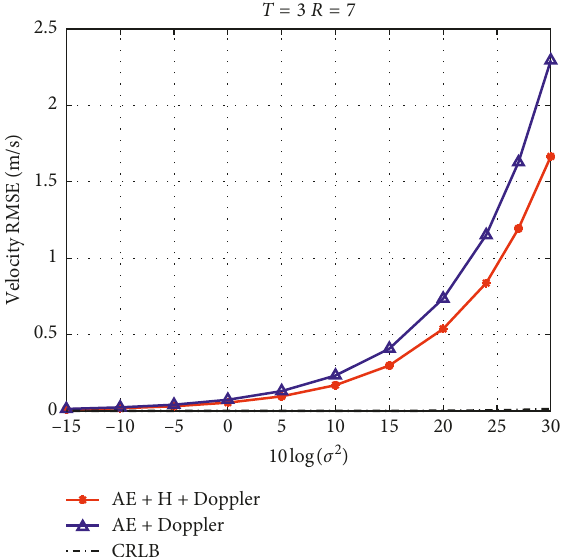
Figure 8: Comparison of the velocity RMSE of the proposed method with AE+Doppler and CRLB when T � 3, R � 7. The CRLB is close to zero, but it is going up as the noise power